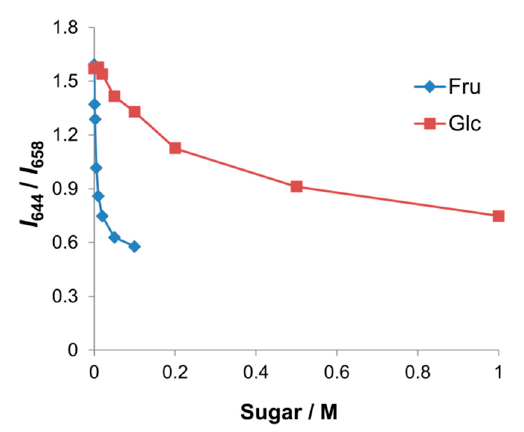
where FR is the fluorescence intensity ratio at 644 nm and 658 nm ( I 644 / I 658 ) for a particular concentration of sugar, FR 0 is the initial fluorescence ratio, FR lim is the limiting (final) fluorescence ratio, and [sugar] is the concentration of sugar. The binding constants ( K ) were determined to be 2.3 × 10 2 M − 1 and 3.1 M − 1 for Fru and Glc, respectively. The dissociation constants ( K d ), which are the reciprocal of K , were calculated to be 4.3 mM and 0.32 M for Fru and Glc, respectively. The sugar-binding ability and selectivity of BRhoC are comparable to those exhibited by JS-R ( K = 1.2 × 10 2 M − 1 for Fru, K = 3.3 M − 1 for Glc) [13], indicating that BRhoC has the potential to be used as a sugar chemosensor.